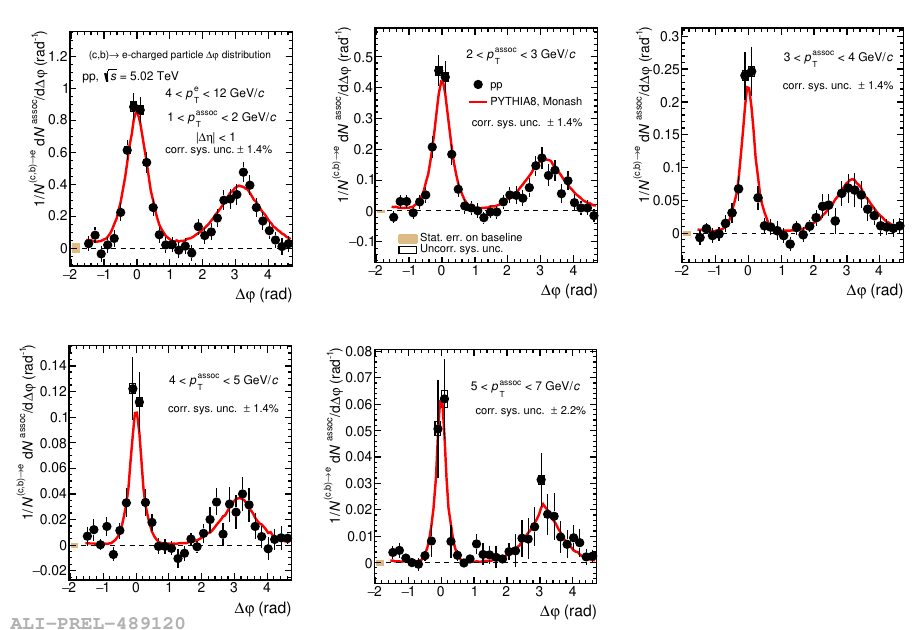
Figure 4. Azimuthal correlation between heavy-flavour hadron decay electrons and charged hadrons in pp collisions at √ s = 5.02